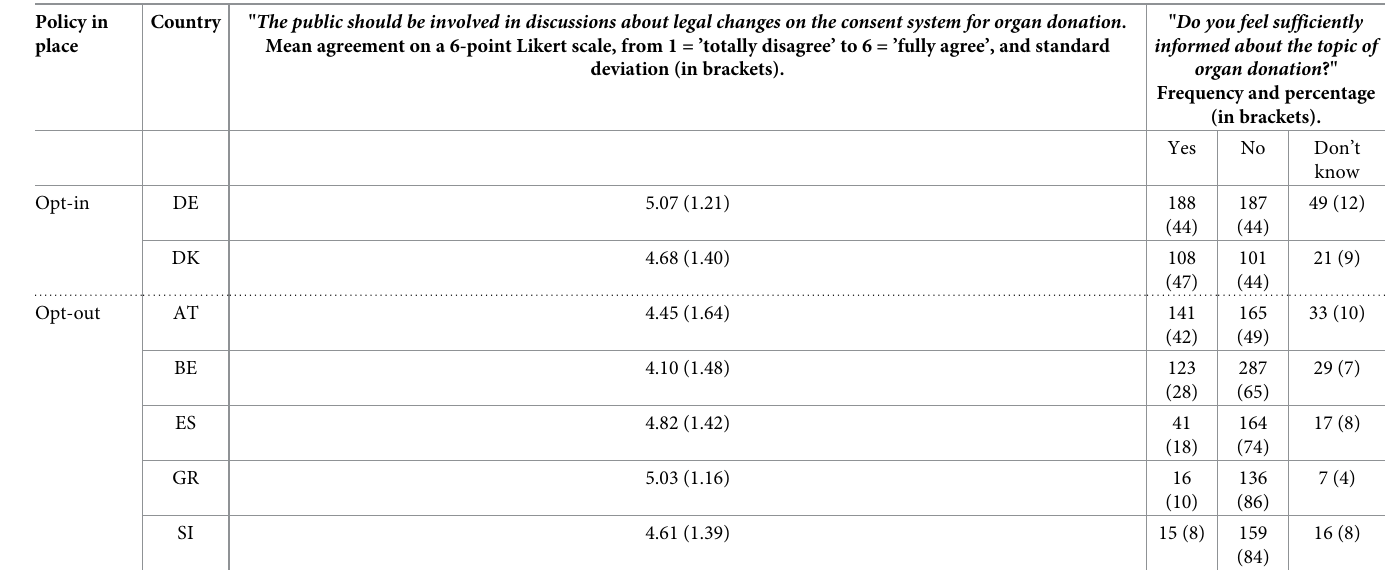
Table 3. Involvement of the public in policy-making and reported knowledge about organ